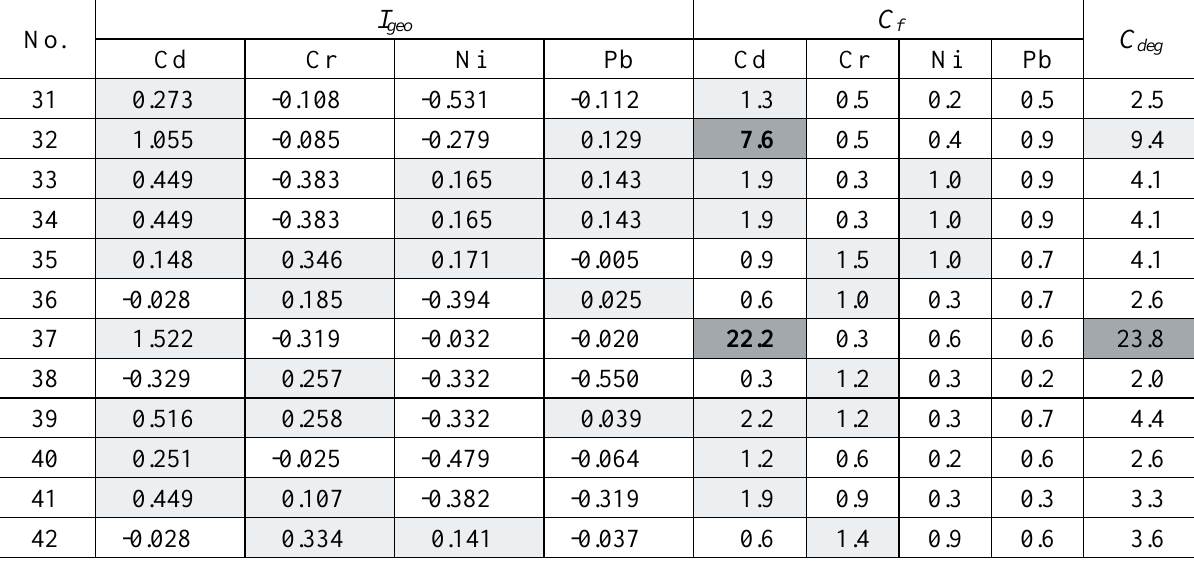
Table 5. Geoaccumulation index ( I geo ) and contamination factor ( C f ) for individual trace elements, and the degree of contamination ( C deg ), in hummocks of raised bogs of the Bolshoy Solovetsky Island. For key to shadings, see the caption of Table